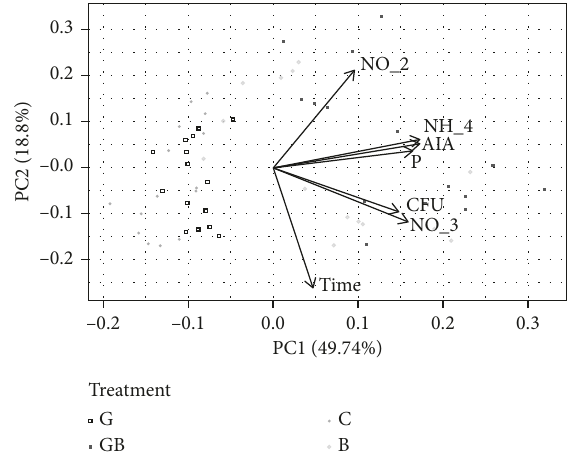
Figure 7: Autoplot showing the results of the principal compo- nents analysis (PCA) to illustrate the relationships between treatments and soil determinations. The length of the vectors in- dicates the influence of the parameter in the ordination of the